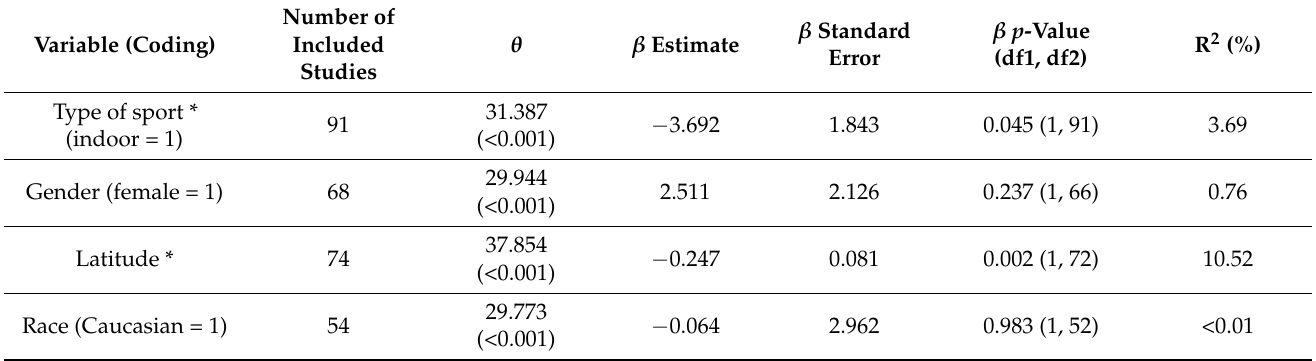
Table 2. The results of bivariate meta-regressions for the following predictors of vitamin D levels: type of sport, gender, latitude, and Asian/Caucasian race. θ = intercept coefficient for each regression model. β = coefficient of the variable for each regression model. * = predictors with significant ( p < 0.05) β